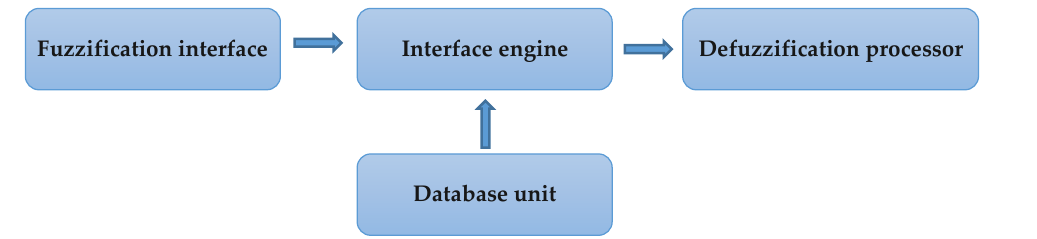
Figure 9. Fuzzy logic controller (FLC) architecture.